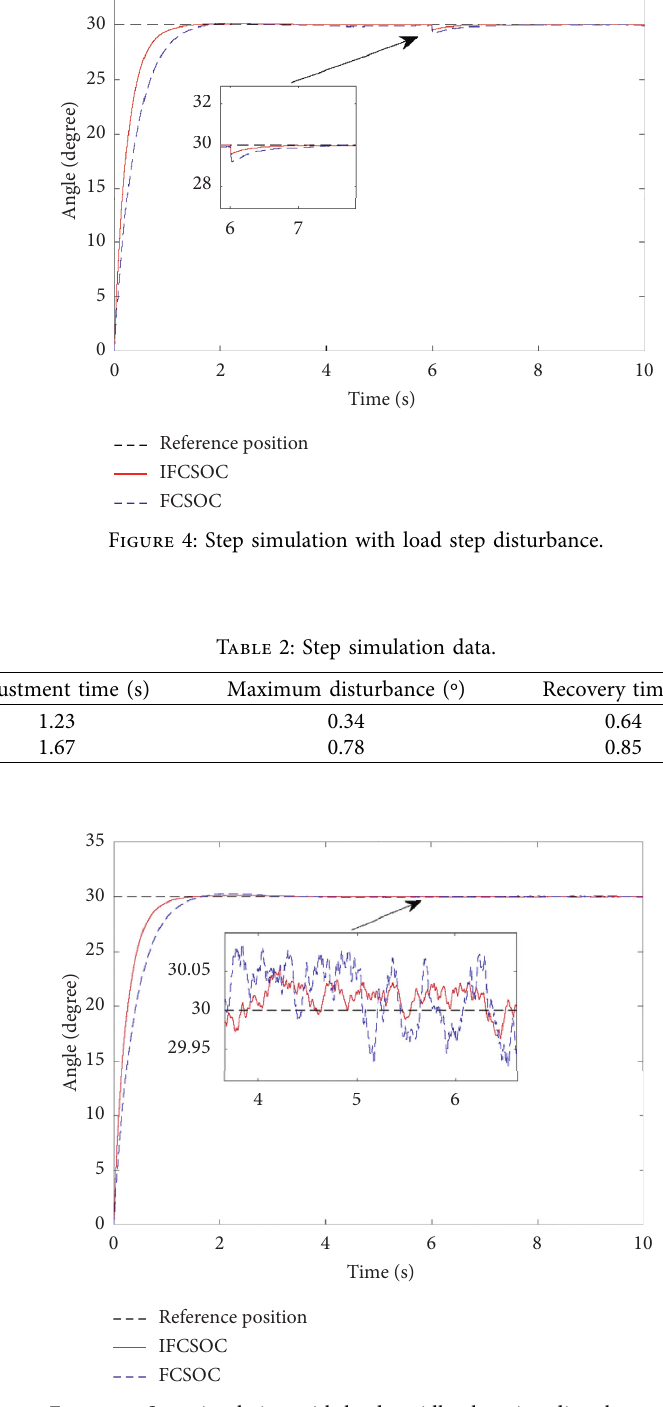
tracking. The parameters of PMSM are listed in Table 1. The NTD parameters are h � 0 . 01 and r C � 1000. The NESO � 1 and β � 15 . 8. The SESO parameters parameters are β 01 02